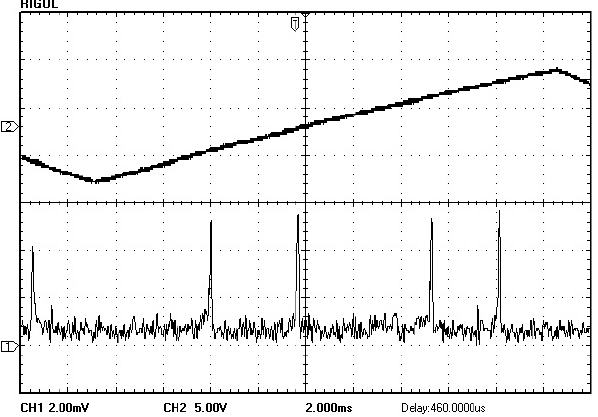
Figure 29. Oscillating mode spectrum of dual-frequency laser [36].